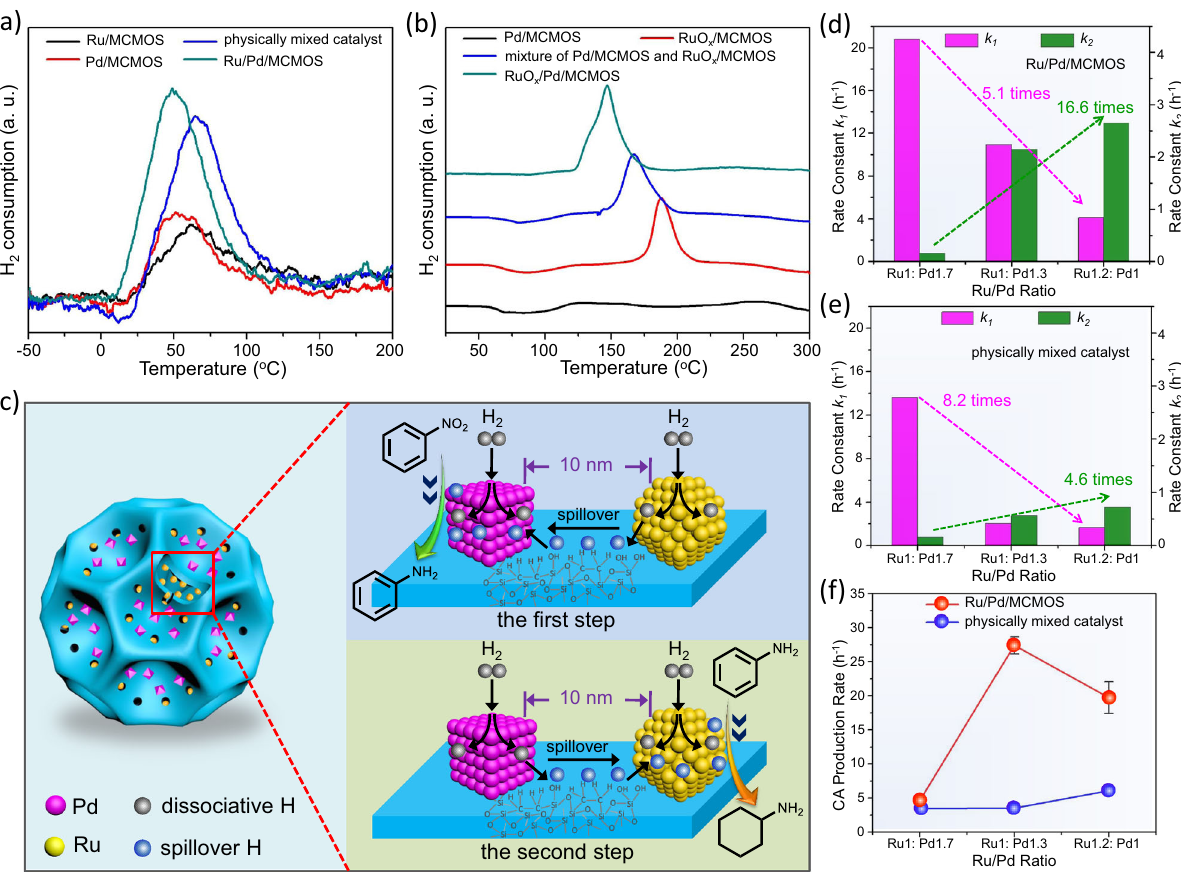
Fig. 4 Neighboring metal-assisted hydrogenation via hydrogen spillover. a H 2 -TPD pro fi les of Pd/MCMOS, Ru/MCMOS, the physically mixed catalyst (Pd/MCMOS + Ru/MCMOS) and Ru/Pd/MCMOS. b H 2 -TPR pro fi les of Pd/MCMOS, RuO x /MCMOS, the mixture of Pd/MCMOS and RuO x /MCMOS, and RuO x /Pd/MCMOS. c Schematic illustration for neighboring metal-assisted hydrogenation over Ru/Pd/MCMOS. d The rate constant of NB ( k 1 ) and AN transformation ( k 2 ) in the sequential hydrogenation reaction over Ru/Pd/MCMOS with different Ru/Pd ratios. e The rate constant of NB ( k 1 ) and AN transformation ( k 2 ) in the sequential hydrogenation reaction over the physically mixed catalysts with different Ru/Pd ratios. f The relationship between the Ru/Pd ratio and the CA production rate in the sequential hydrogenation